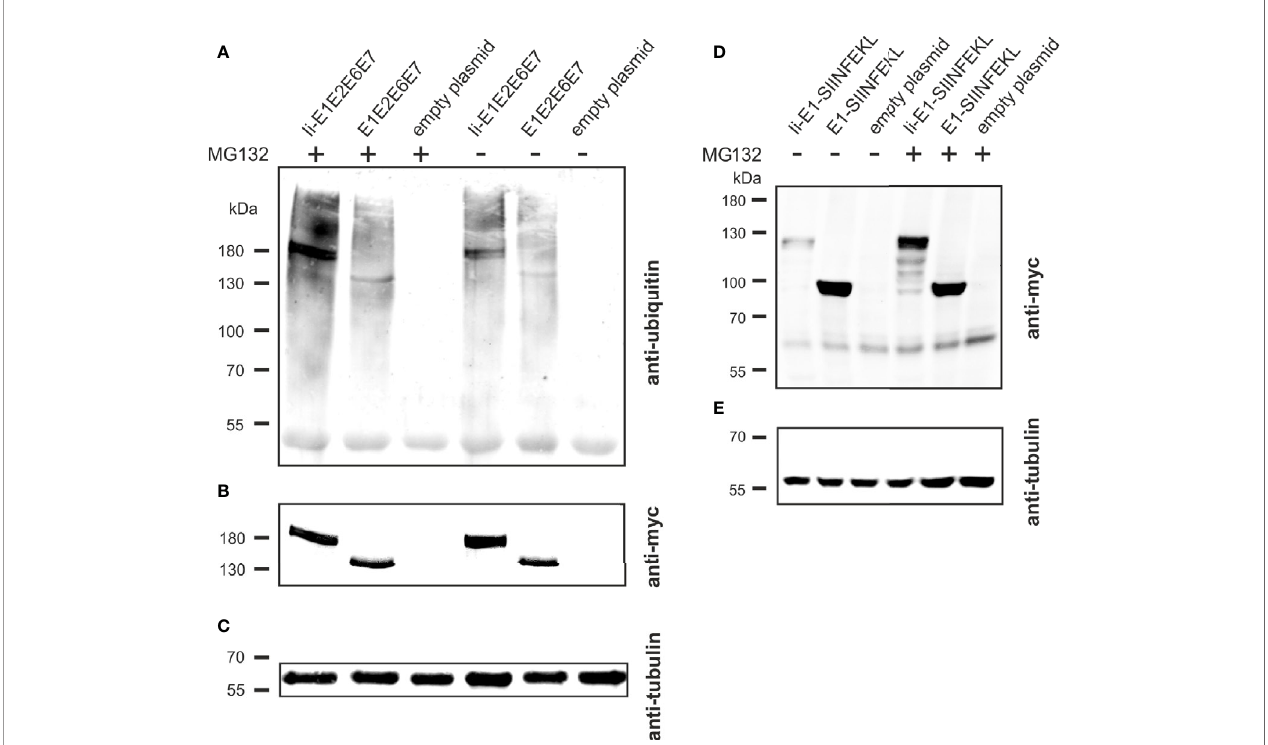
FIGURE 7 | In fl uence of Ii on ubiquitination and degradation. (A – C) pURVac Ii-E1E2E6E7, pURVac E1E2E6E7 or the empty plasmid were transfected into HEK293T cells. 24 h after transfection, cells were treated with MG132 or DMSO as control for 6 h. Myc-tagged proteins were immunoprecipitated and analyzed by western blot using an anti-ubiquitin antibody (A) and anti-myc antibody (B) . Tubulin levels were monitored using an anti-tubulin antibody as loading control (C) . (D, E) pURVac Ii-E1- SIINFEKL, pURVac E1-SIINFEKL or empty plasmid were transfected into HEK293T cells. 24 h after transfection, cells were treated with MG132 or DMSO for 6 h. The samples were analysed by western blot using anti-myc antibody (D) and anti-tubulin antibody (E)